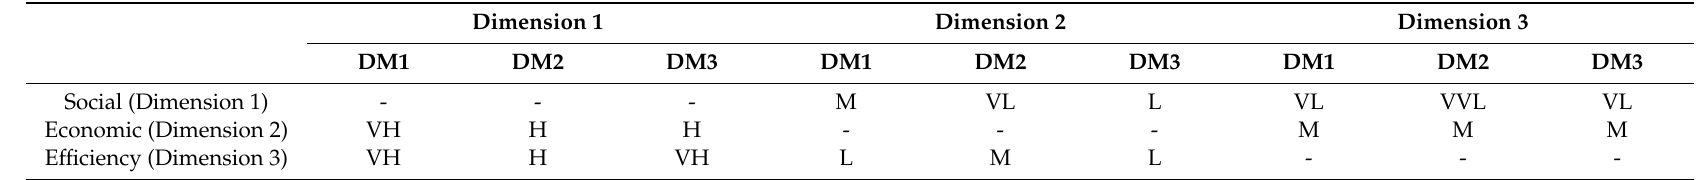
Table A1. Experts’ evaluations for the dimensions.